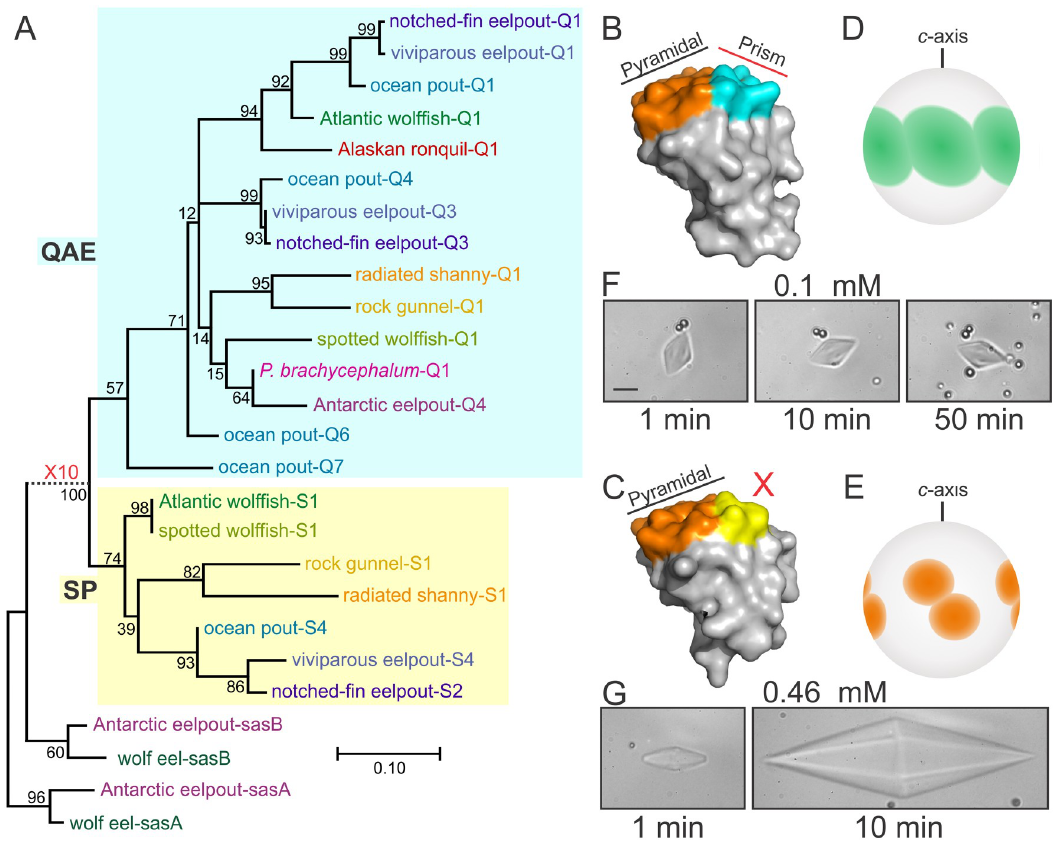
Fig 3. Phylogenetic and functional comparison of type III AFPs. A) A maximum-likelihood phylogenetic tree of the nucleotide sequences (S4 Fig) of the subset of type III AFP sequences shown in Fig 2. Cyan and yellow backing denotes QAE and SP isoforms respectively and bootstrap values (percent) are indicated at most nodes. The scale bar represents an average of 0.1 or 1 changes per site for solid and dashed lines respectively. B) and C) Representative structure of a QAE (PDB:4UR4) and SP isoform (PDB:4UR6) respectively [53] with the pyramidal and prism ice-binding surfaces colored orange and cyan respectively [78]. D) and E) Diagram of the fluorescent ice-plane affinity of a QAE and SP isoform respectively, adapted from previously published images [79]. F) and G) Ice crystals in the presence of 0.1 mM of a fully-active QAE isoform (M1.1, [91]) and 0.46 mM of an SP isoform (notched-fin eelpout-S5, S3 Fig [27]) respectively. Samples were cooled at a rate of 0.01˚C/6 sec for one min then held for the indicated times at 0.1˚C below the melting point. The scale bar represents 10 μ